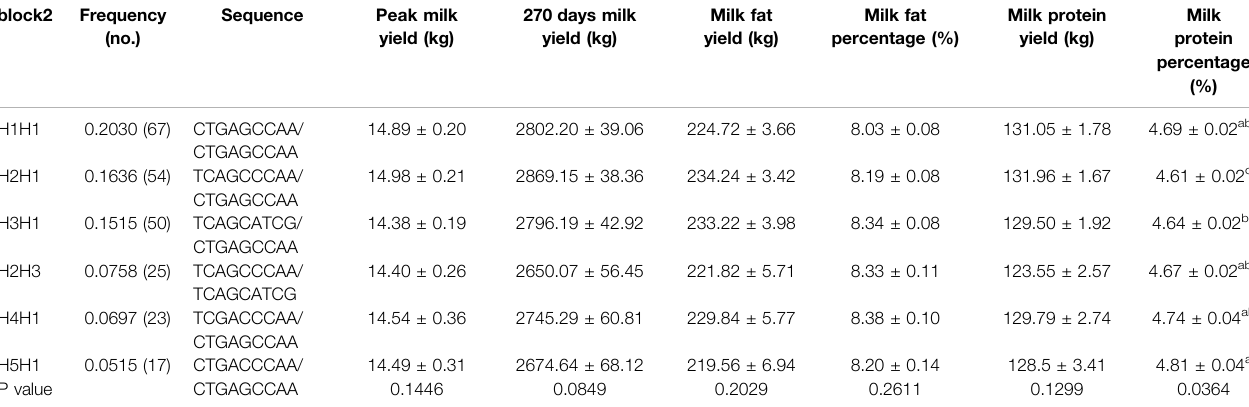
TABLE 3 | Assocation analysis between haplotypes of block 2 in the ACSL1 gene and milk production traits. block2 Frequency (no.)